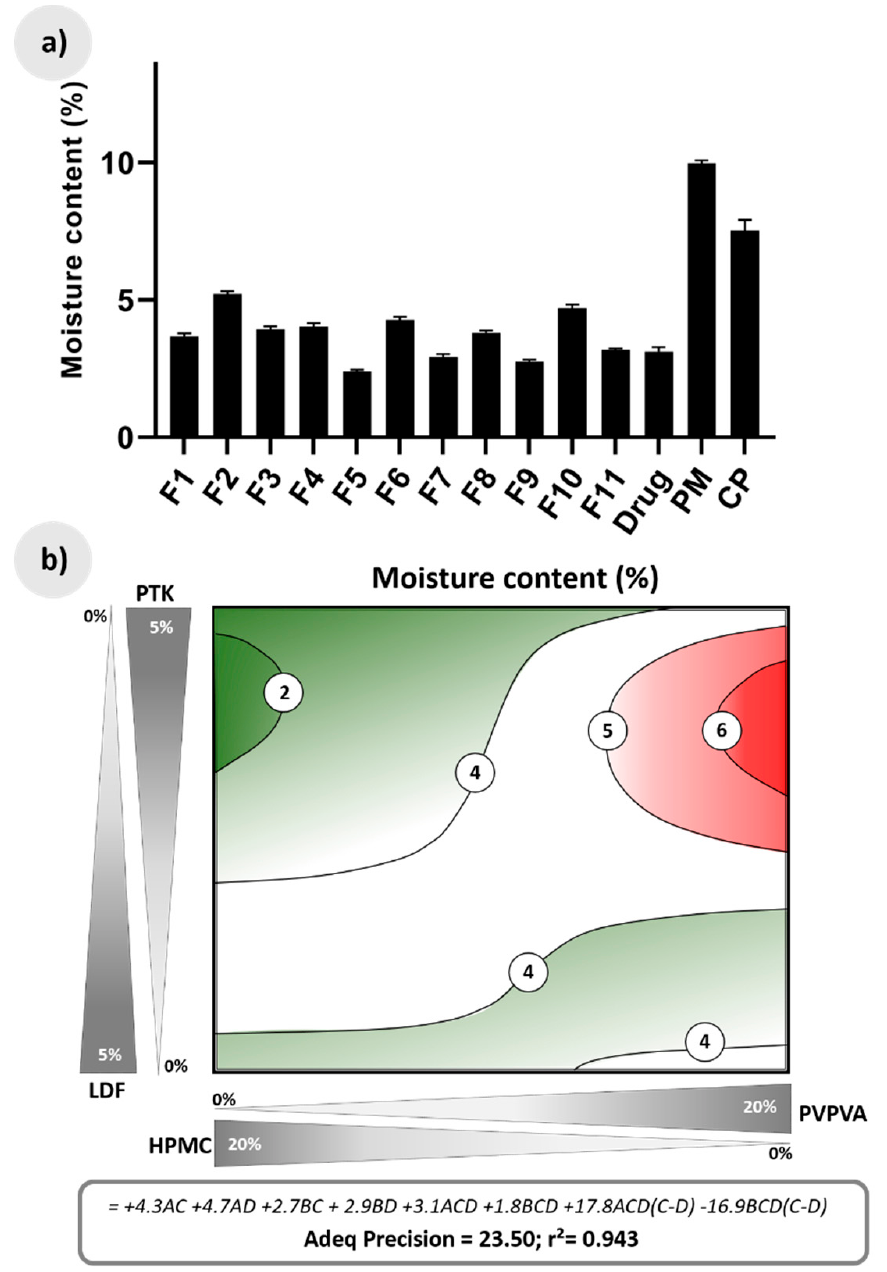
Figure 4. ( a ) Moisture content (%) of the drug as supplied, the physical mixture containing drug and effervescent salts (PM), commercial drug product (CP), and effervescent extrudates after aging; ( b ) Response surface for moisture content according to a linear-cubic model, together with its predictive equation (A = PVPVA, B = HPMC, C = PTK, and D = LDF). The green regions show compositions with low moisture levels, and the red regions indicate compositions with high moisture levels.